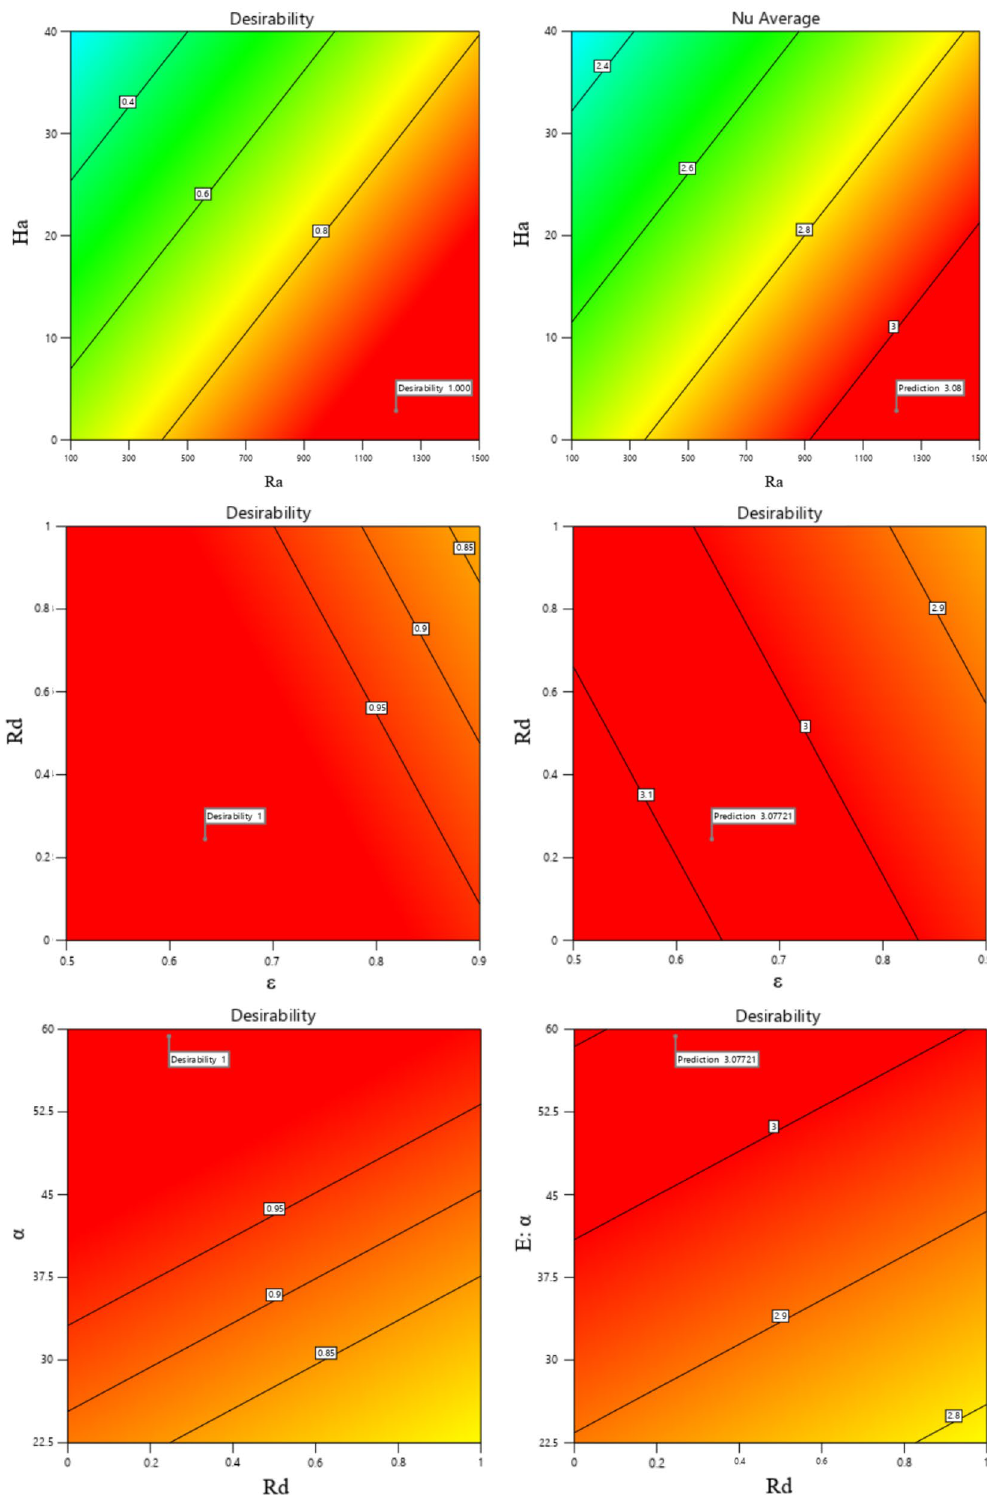
Figure 24. Desirability diagram of different working parameters on average Nu number by